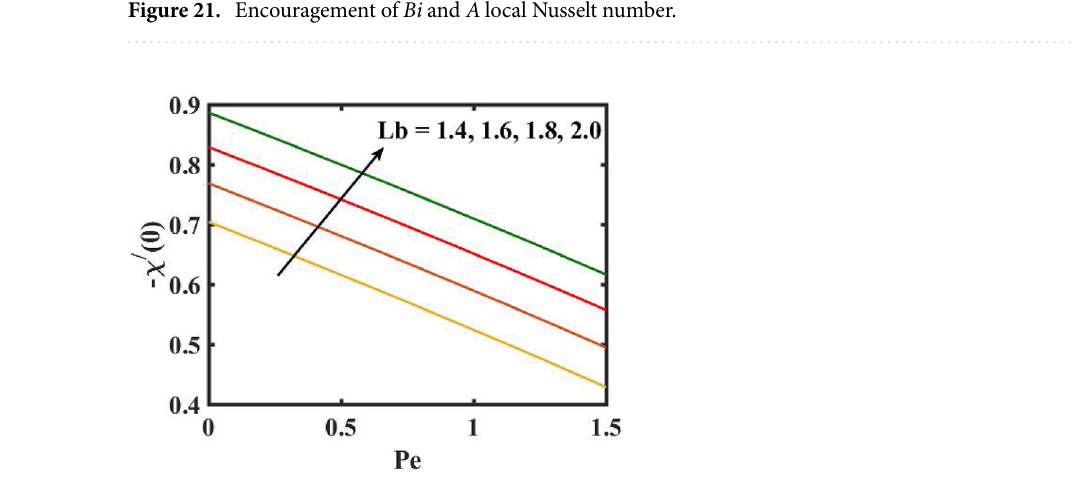
Figure 22. Encouragement of Lb and Pe on local density number of motile